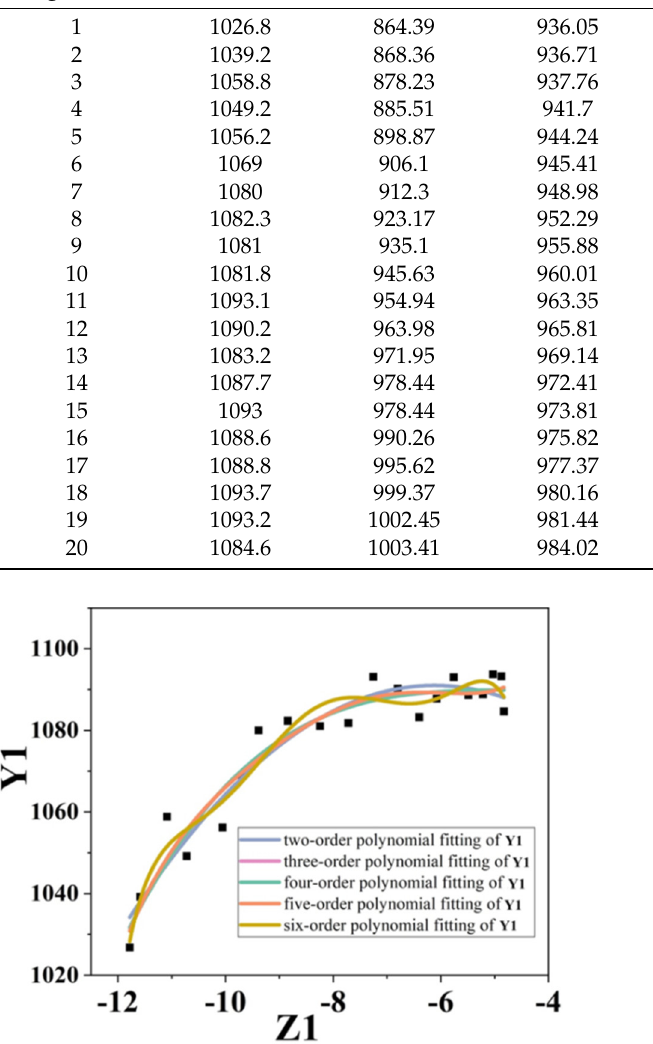
Figure 2. Five different polynomial fitting curves for RPM(Z) and EGT1(Y1).